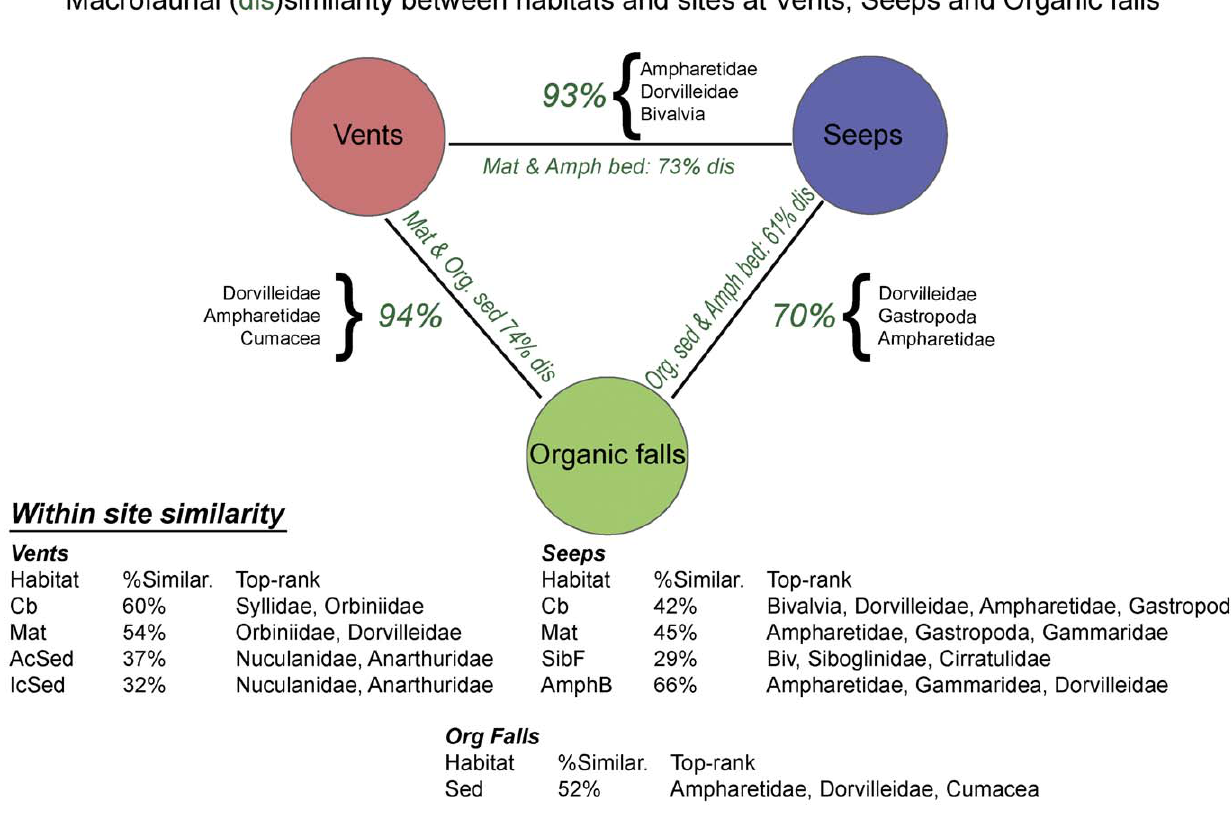
Figure 7. Diagram showing degree of community similarity or dissimilarity between chemosynthetic ecosystems and habitats. Values outside bars denote average dissimilarity between sites with all habitats combined and taxa responsible for those differences. Values inside bars indicate the lowest dissimilarity between two habitats among the two sites compared. Legend: Green color – indicates dissimilarity percentages from SIMPER analysis.